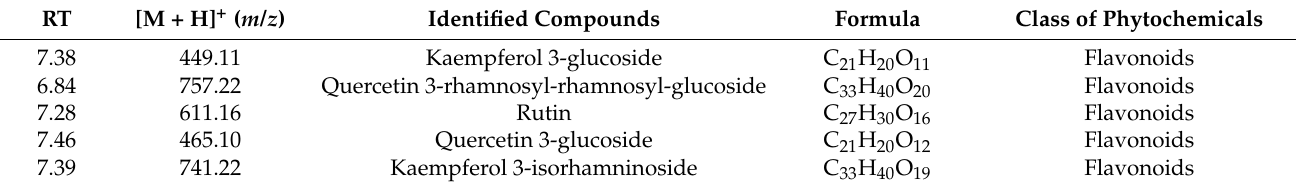
Table 1. Main compounds in CT extract, as assayed by reverse-phase ultra-high performance liquid chromatography coupled with quadru-pole time-of-flight mass spectrometry. RT [M + H] + ( m/z